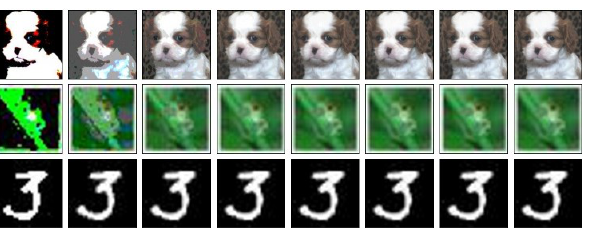
Figure 3. Bit-depth compression examples, sorted from left to right by bit-depth values, ranging from 1 to 8 (original image). ( Top ) images: from ImageNet, ( middle ): CIFAR10, and ( bottom ):